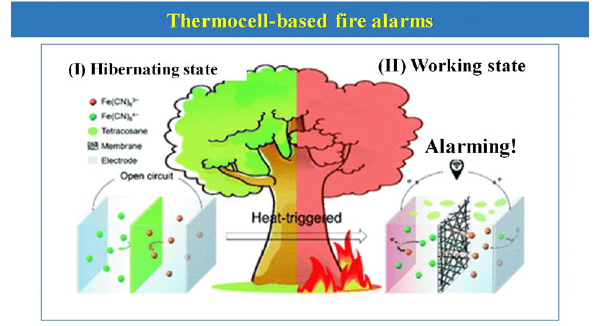
Fig. 13 Schematic diagram of the thermocell device in both hiber‑ nating and working state. Reproduced with permission from